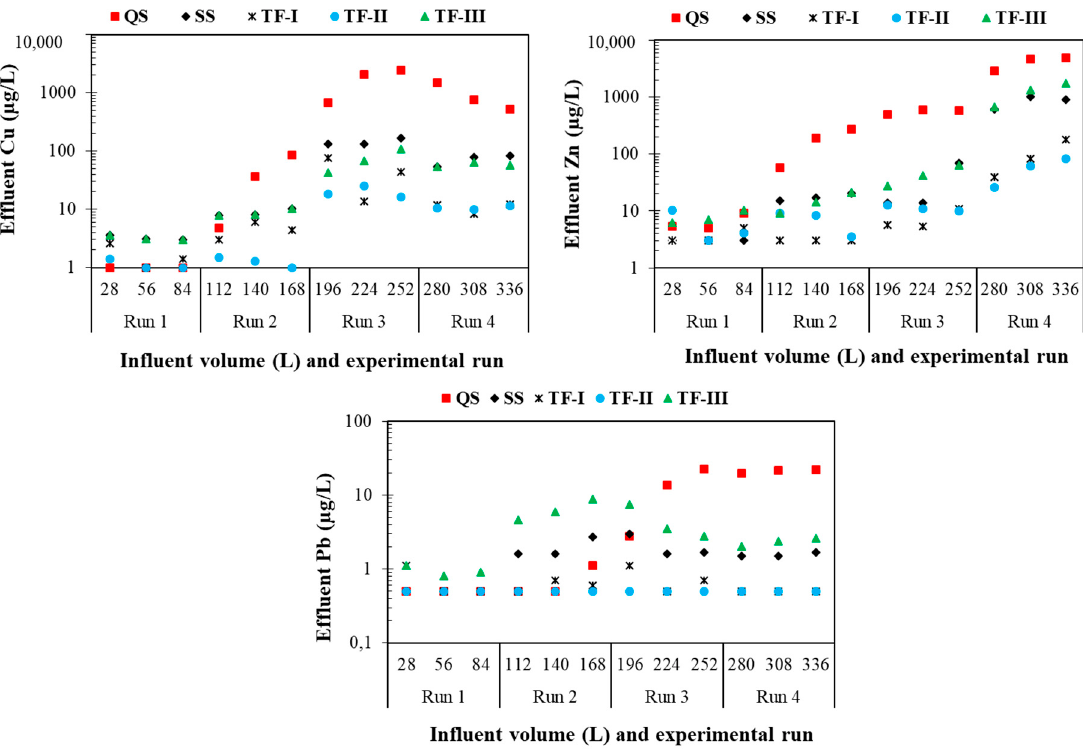
Figure 2. Effluent concentrations of heavy metals with different synthetic stormwater dosings (Run 1–Run 4, see Table 2) under high hydraulic load experimental conditions as a function of treated volume.